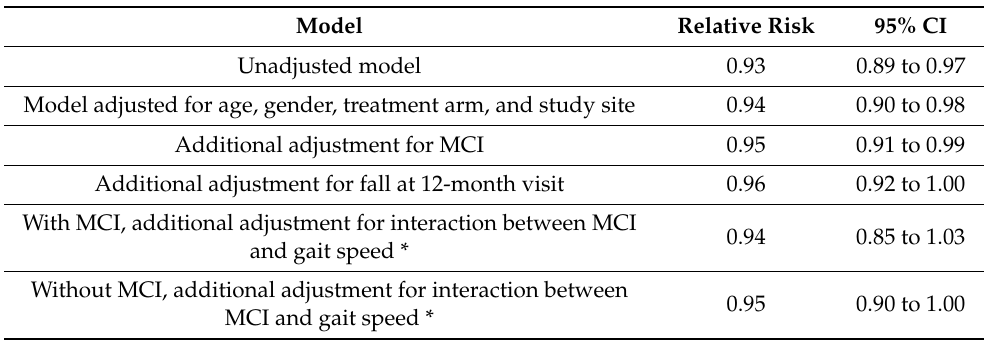
Table 3. The association (RR, 95% CI) between preferred gait speed (10 cm/s) and falls in 2705 older adults participating in GEMS. Model Relative Risk 95% CI Unadjusted model 0.93 0.89 to